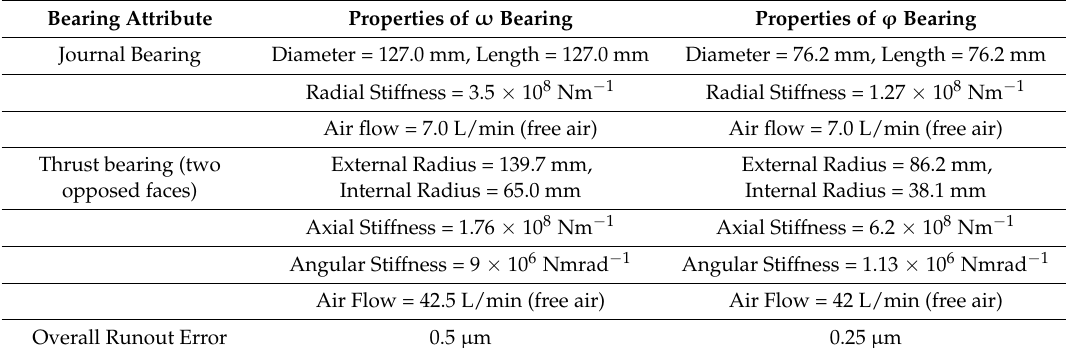
Table 1. Properties of the ω and φ bearings used in the goniometer.